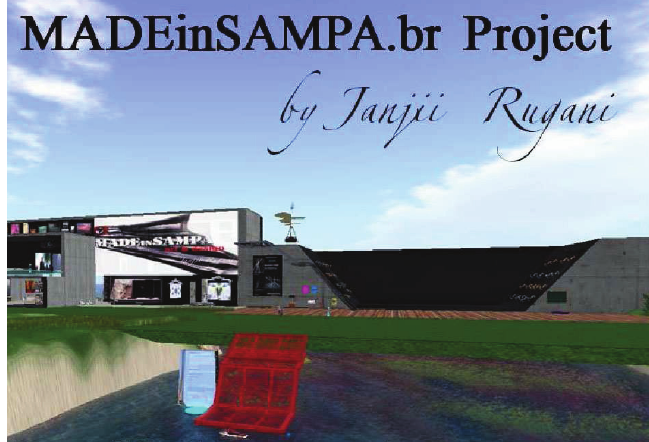
Fig. 2. MADEinSAMPA.br Project at Second Life